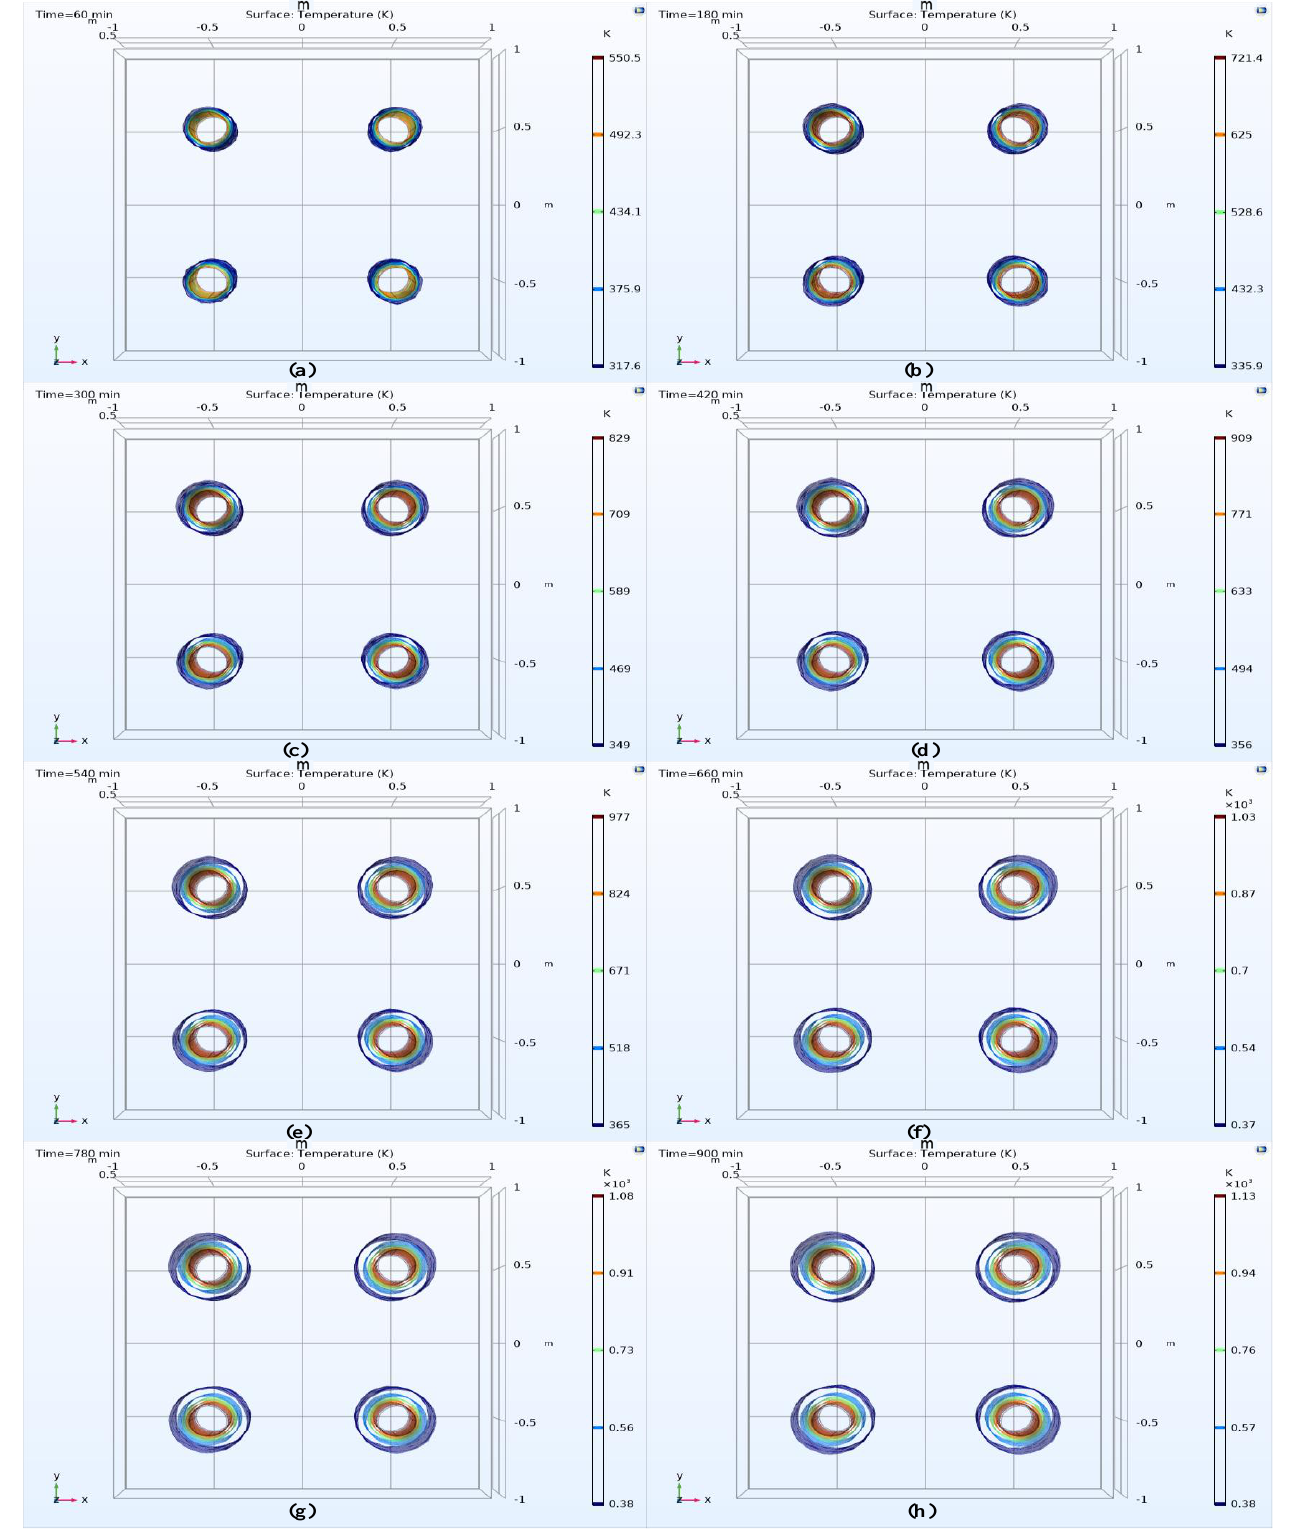
Figure 6. Temperature isosurface in porous medium model in 1~15 h. Subfigures (a)-(h) show the temperature isosurface of porous media every two hours after the first hour of simulation. The temperatures of different surfaces are given in the legend.